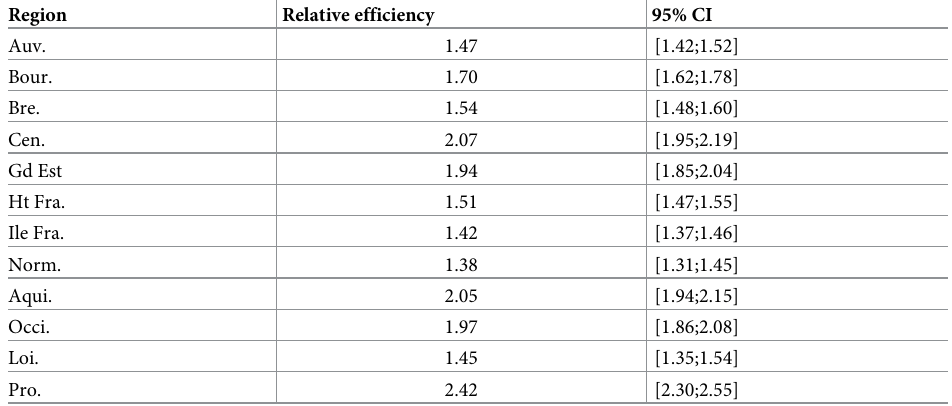
Table 13. One-week ahead estimate—relative efficiency being higher than one suggests increased predictive power of ARGONet compared to the autoregressive model AR(52). Region Relative efficiency 95% CI Auv.